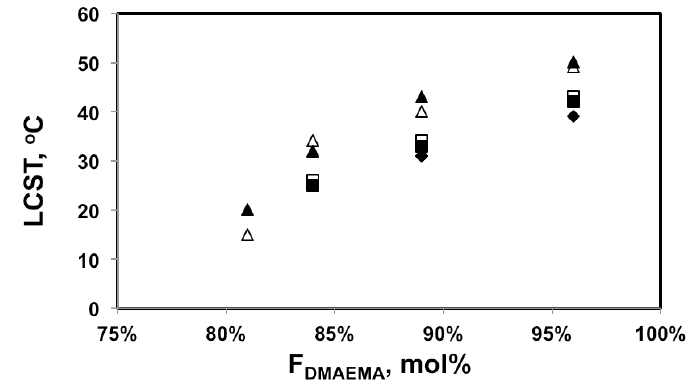
Figure 7. LCST of poly(DMAEMA- stat -styrene) as a function of DMAEMA molar composition in the copolymer ( F ) in de-ionized water at 0.1 wt% ( ▲ ), 0.3 wt% ( (cid:132) ) DMAEMA and 0.5 wt% ( (cid:139) ) concentration; filled symbols are DLS results and hollow symbols are UV-Vis results.